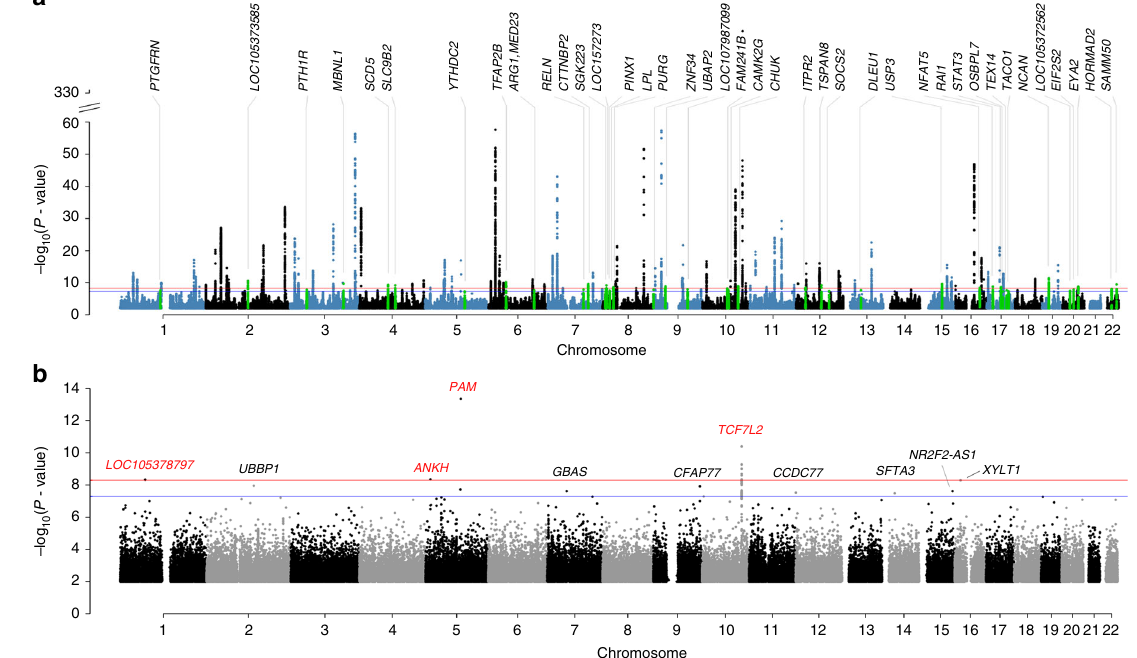
Fig. 1 Manhattan plots of common- and rare-variant associations for T2D. a GWAS results for common variants (MAF ≥ 0.01) in the meta-analysis. The 39 novel loci are annotated and highlighted in green. b GWAS results of rare variants (0.0001 ≤ MAF < 0.01) in UKB. Four loci with P < 5 × 10 − 9 are highlighted in red. The blue lines denote the genome-wide signi fi cant threshold of P < 5 × 10 − 8 , and the red lines denote a more stringent threshold of P < 5 × 10 −